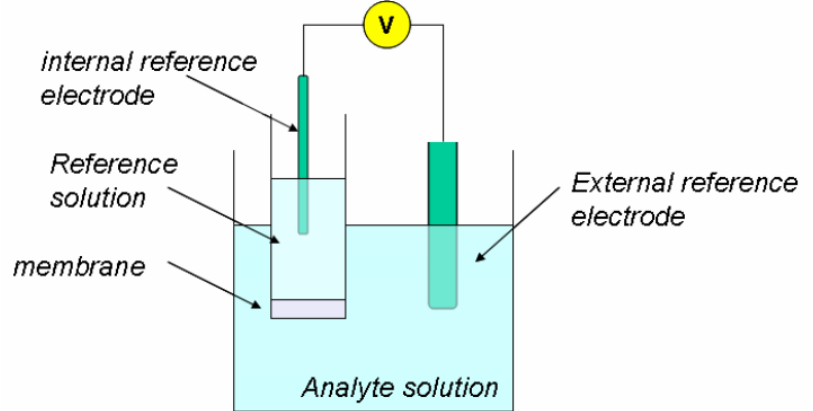
Figure 6. Electrochemical cell for a potentiometric measurement with ISE. [Reprinted from ref. [45], by Pavan M. V. Raja & Andrew R. Barron; via OpenStax CNX (CC BY